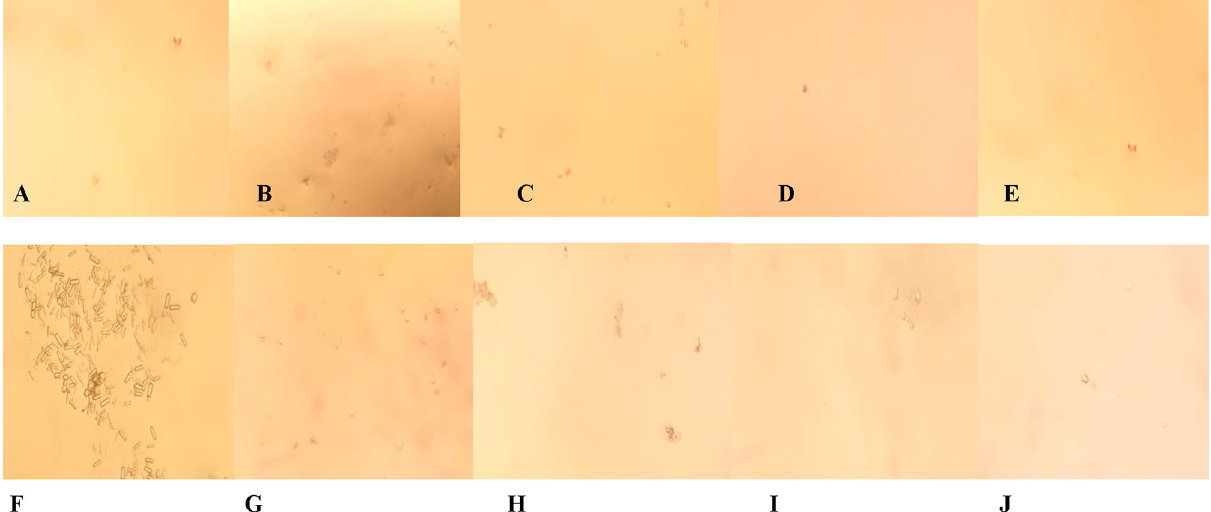
Figure 1. Light microscopic examination of the urine samples under the microscope at 10 × 10X magnification showing multiple crystals in the EG treated group. ( A ) Control group; ( B ) Cystone treated group; ( C ) Bee pollen treated group 100 mg; ( D ) Bee pollen treated group 250 mg; ( E ) Bee pollen treated group 500 mg; ( F ) EG treated group; ( G ) EG + Cystone treated group; ( H ) EG + Bee pollen treated group 100 mg; ( I ) EG + Bee pollen treated group 250 mg; ( J ) EG + Bee pollen treated group 500